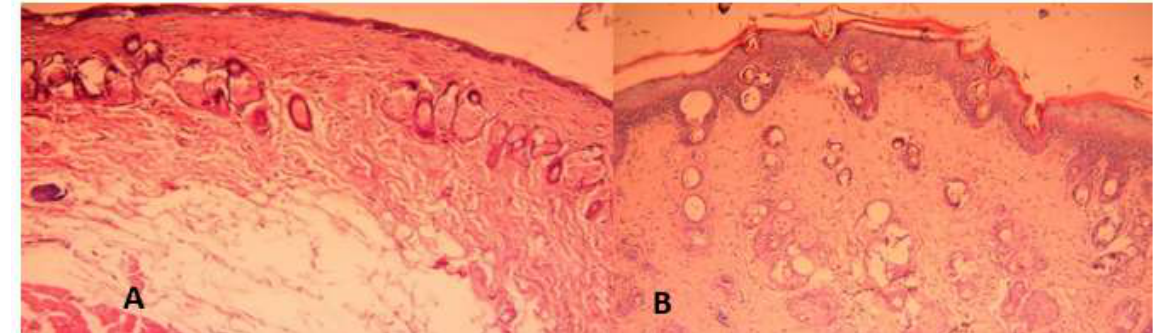
Figure 4. Histopathological changes in topically induced AD group (B) in comparison with controls (A) (10x): ordinary Hematoxylin and eosin stain.